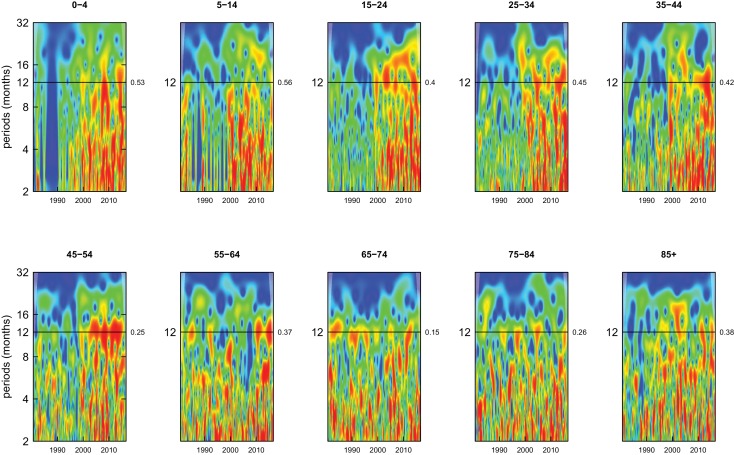
Wavelet power spectra for national time series of substance use disorder death rates for 1980–2016, by age group for females.Wavelet power values increase from blue to red. The shaded regions at the left and right edge of each box indicate the cone of influence, where spectral analysis is less robust. P-values for the presence of 12 month seasonality are to the right of each figure at the 12 month line.